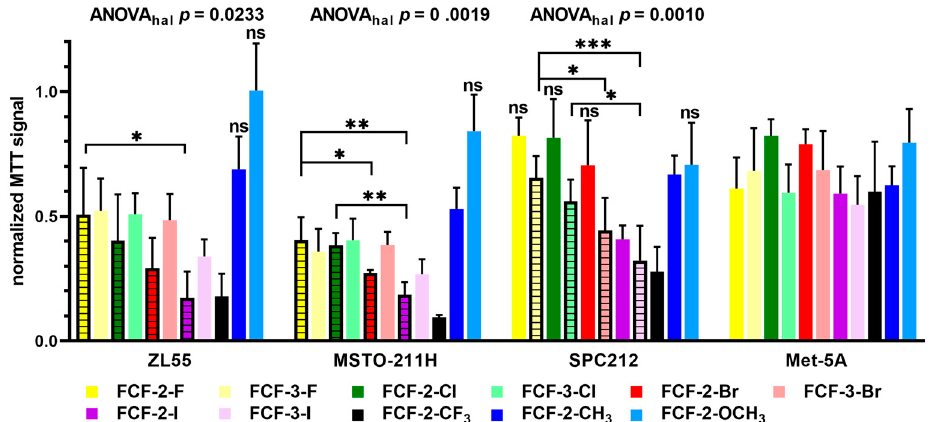
Figure 1. Cell proliferation/viability-decreasing effect of FCF and 10 FCF analogs in human MM cells (ZL55, MSTO-211H, SPC212) and immortalized (untransformed) Met-5A mesothelial cells. The cells were exposed to FCF and 10 analogs (for nomenclature, see Supplementary Information) at a concentration of 50 µ M, and MTT assays were performed 96 h after the beginning of the treatment. The bars represent the mean ( ± SD) of 4–5 independent experiments, and each condition was measured in three wells. In each independent experiment, the MTT signal of the untreated cells (medium containing 0.125% DMSO) of each cell line was set to 1.0. For the ZL55 and MSTO-211H cells, the bars for the FCF analogs with halogen atoms in the 2-position of the pyridine ring are stippled; for SPC212 cells, the stippled bars represent the halogenated FCF analogs with modifications in the 3-position. In all of the MM cell lines (but not in untransformed Met-5A) the ANOVA of all of the experimental conditions including the control cells revealed significant differences ( p < 0.0001) among the compounds. Pairwise comparisons (control vs. FCF compounds) showed significant decreases (Supplementary Table S1), except where they are marked as not significant (n.s.). The grouping of the four single-halide compounds in the 2-position (ZL55 and MSTO-211H) or the 3-position (SPC212) are marked by asterisks. *, ** and *** represent p < 0.05, p < 0.01 and p < 0.001,